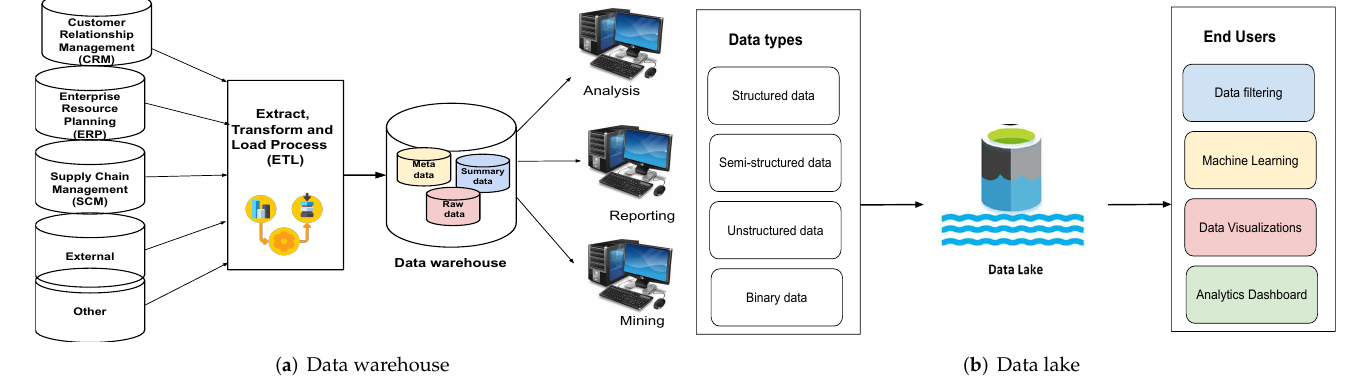
Figure 1. Data warehouse architecture vs. data lake